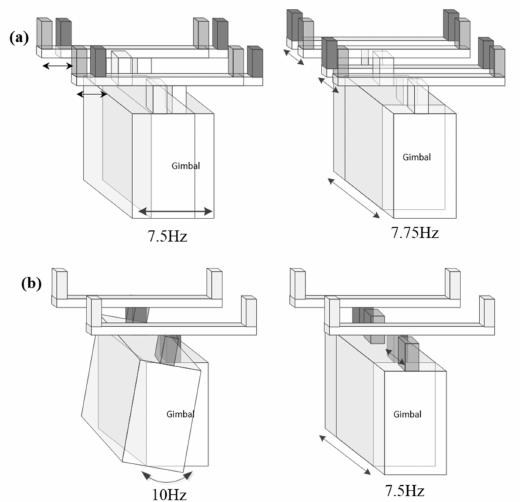
Figure 10. Mode shape of rigid body modes for ( a ) initial and ( b ) optimal designs from measurement and prediction.